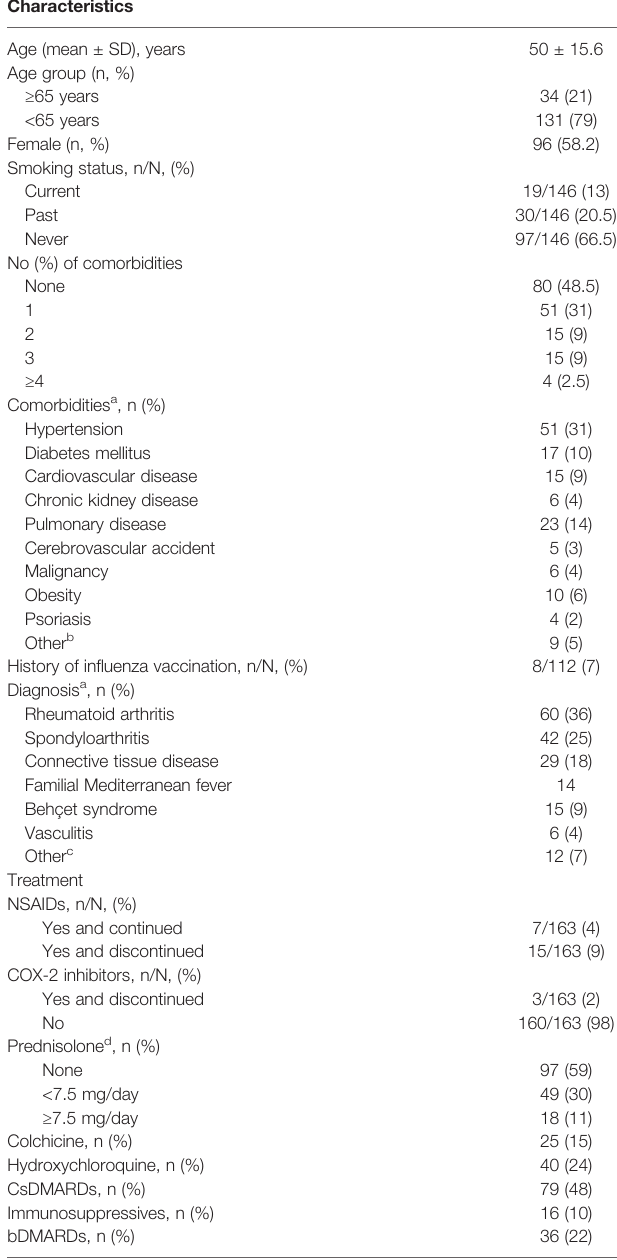
TABLE 1 | Demographics, clinical characteristics, IRD diagnoses and rheumatic drugs of IRD patients with COVID-19.